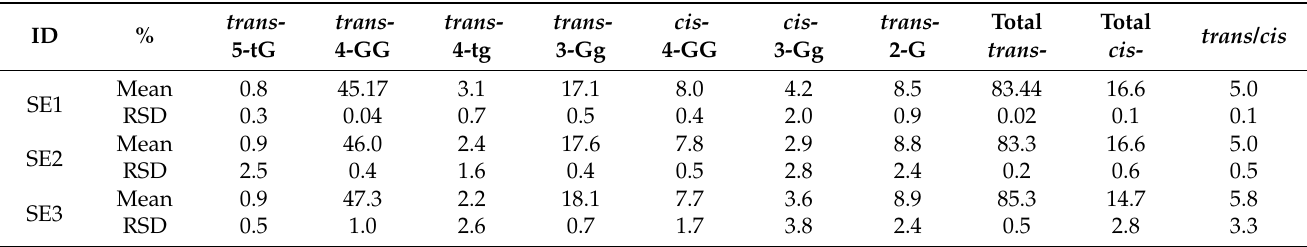
Table 3. Crocin content (as % of total crocins) of saffron extracts (SE), raw saffron stigmas (SS) and gardenia extract